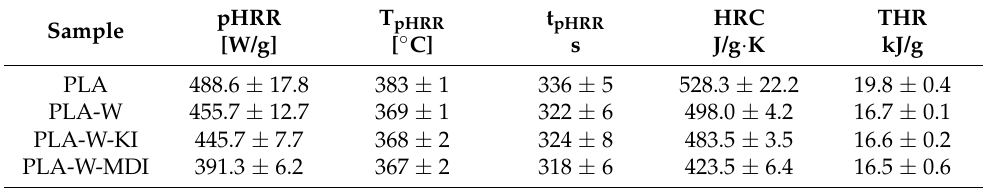
Table 4. Results of microcalorimetry investigations of PLA and PLA